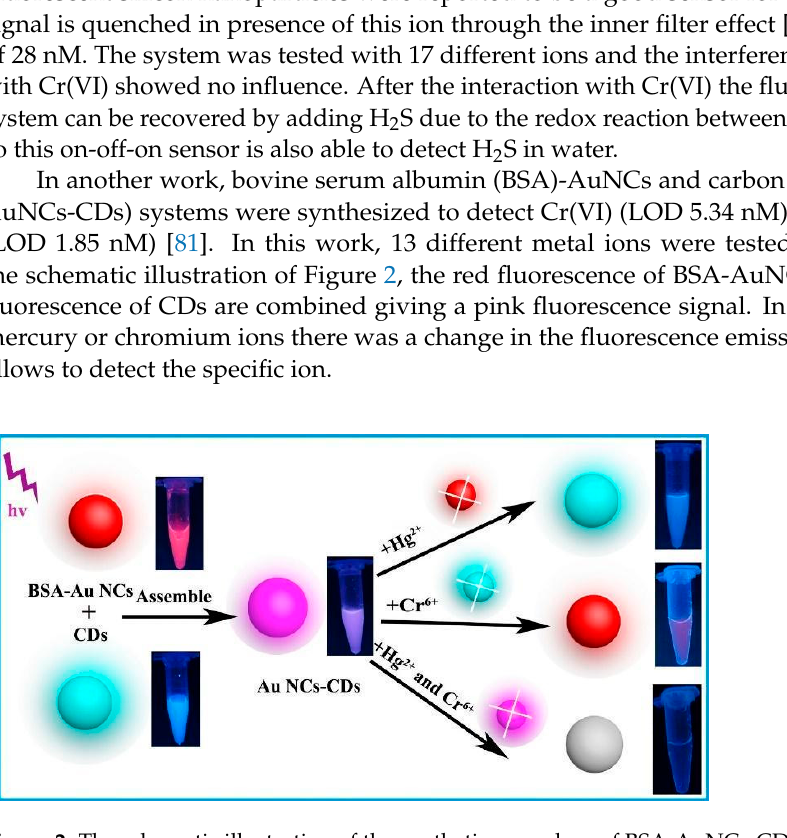
Figure 2. The schematic illustration of the synthetic procedure of BSA-AuNCs-CDs and detection of metal ions by BSA-AuNCs-CDs. (Reprinted from reference [81] with permission from